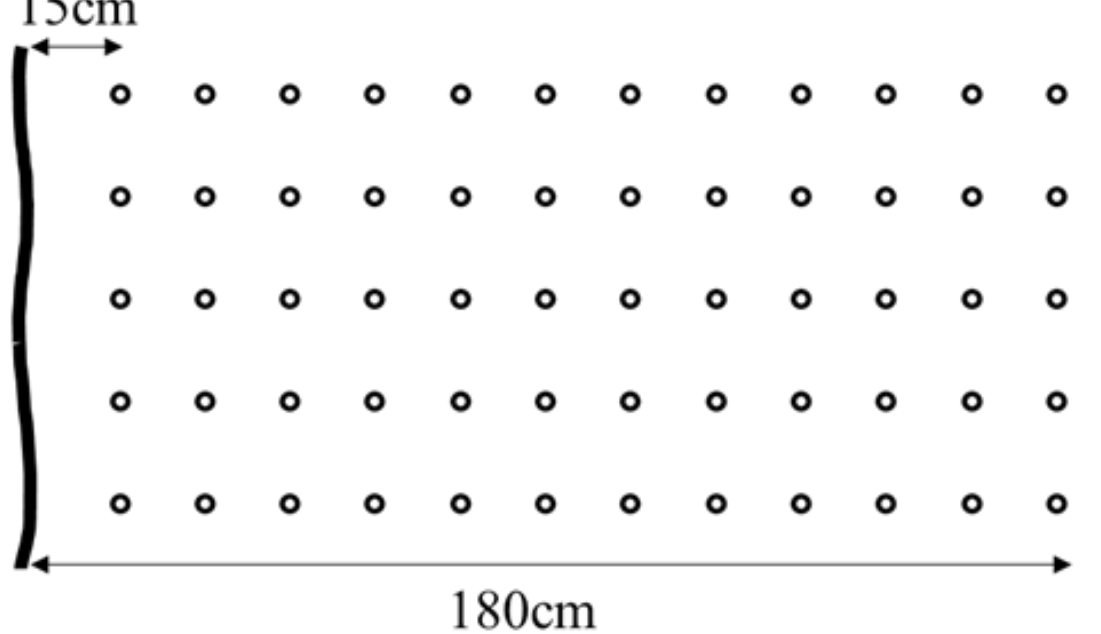
Figure 5. The location of the soil water content measurements at different distances from the cracks.